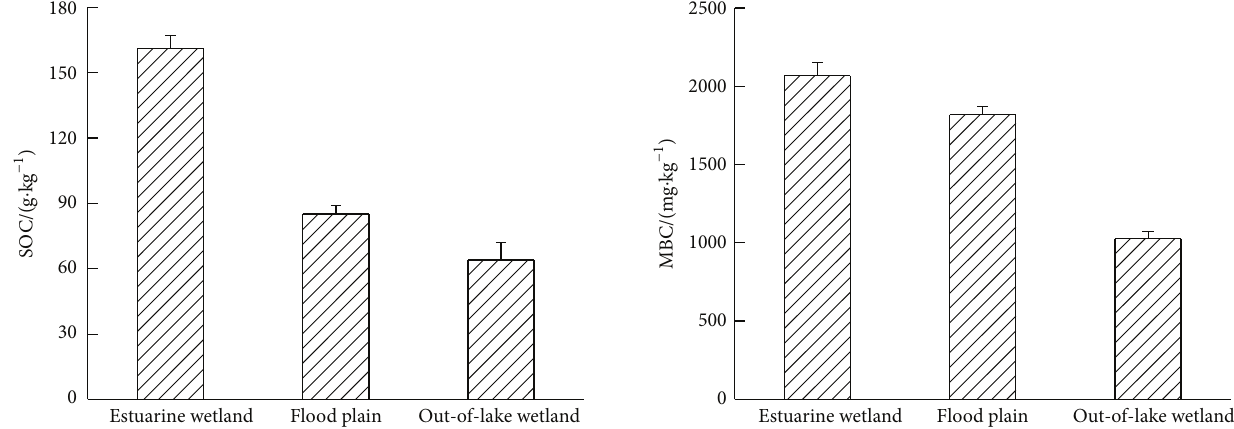
Figure 1: Changes of SOC content under different types of wetland in Hongze Lake of China.